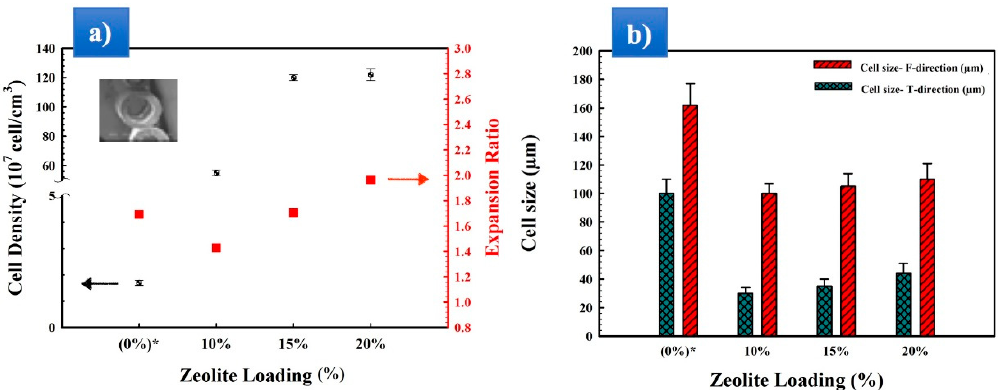
Figure 5. ( a ) Cell density and expansion ratio, ( b ) average cell sizes in the transverse (T) and flow (F) directions of mixed matrix foam membrane (MMFMs) with different zeolite contents (0, 10, 15, and 20 wt %) at a stretching speed of 5 m/min.